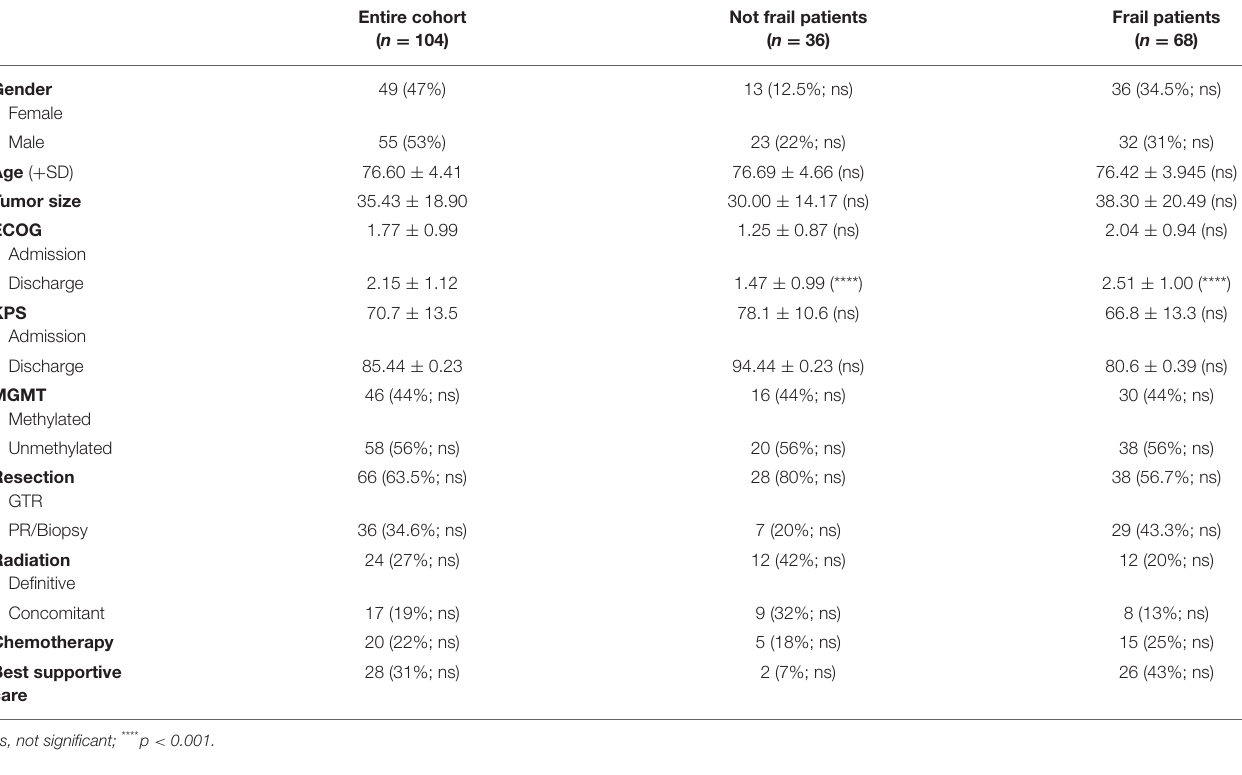
Not frail patients ( n = 36)